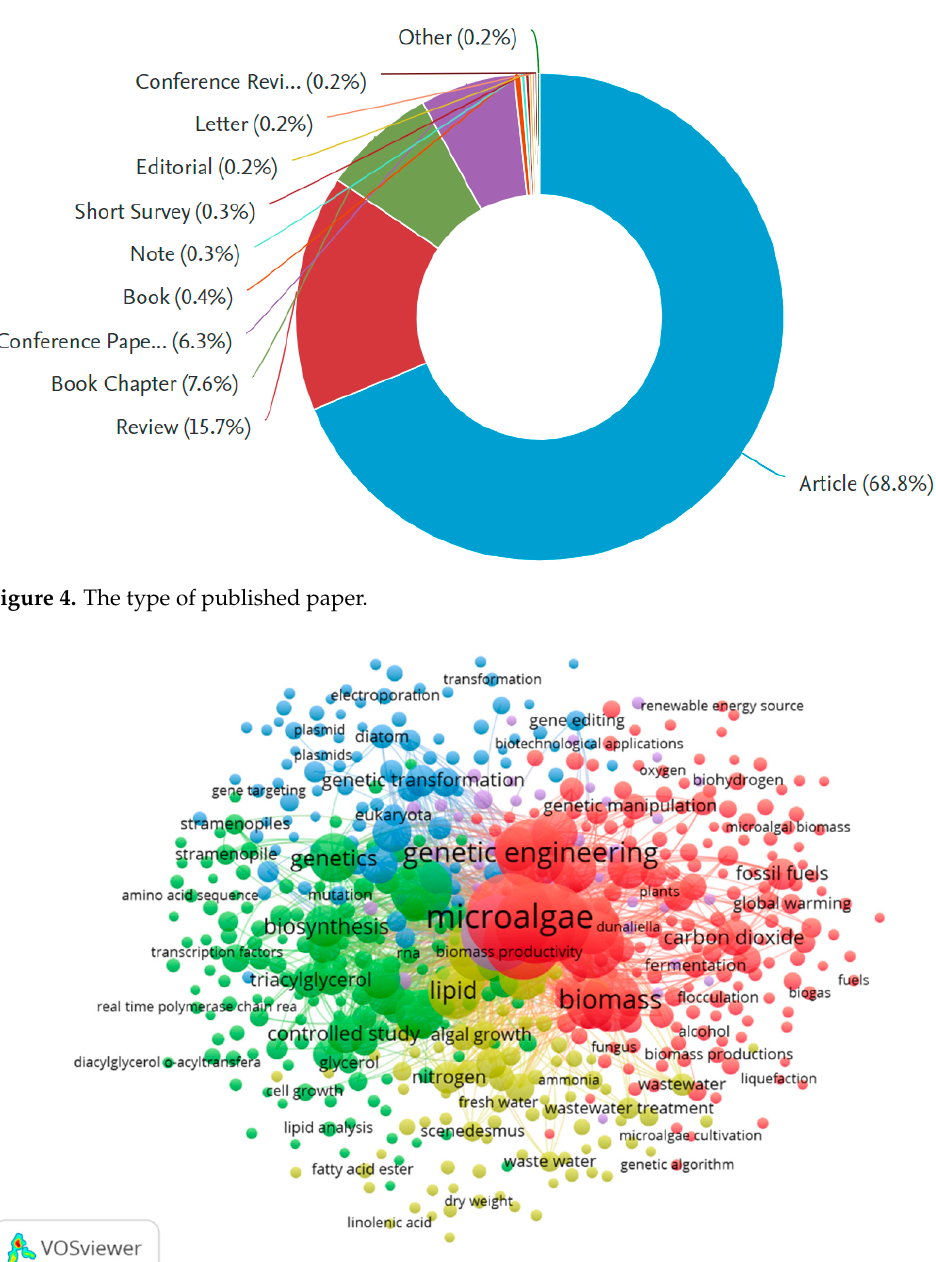
Figure 5. Visual demonstration of the network of keywords co-occurrences and connections obtained via the VOSviewer software.